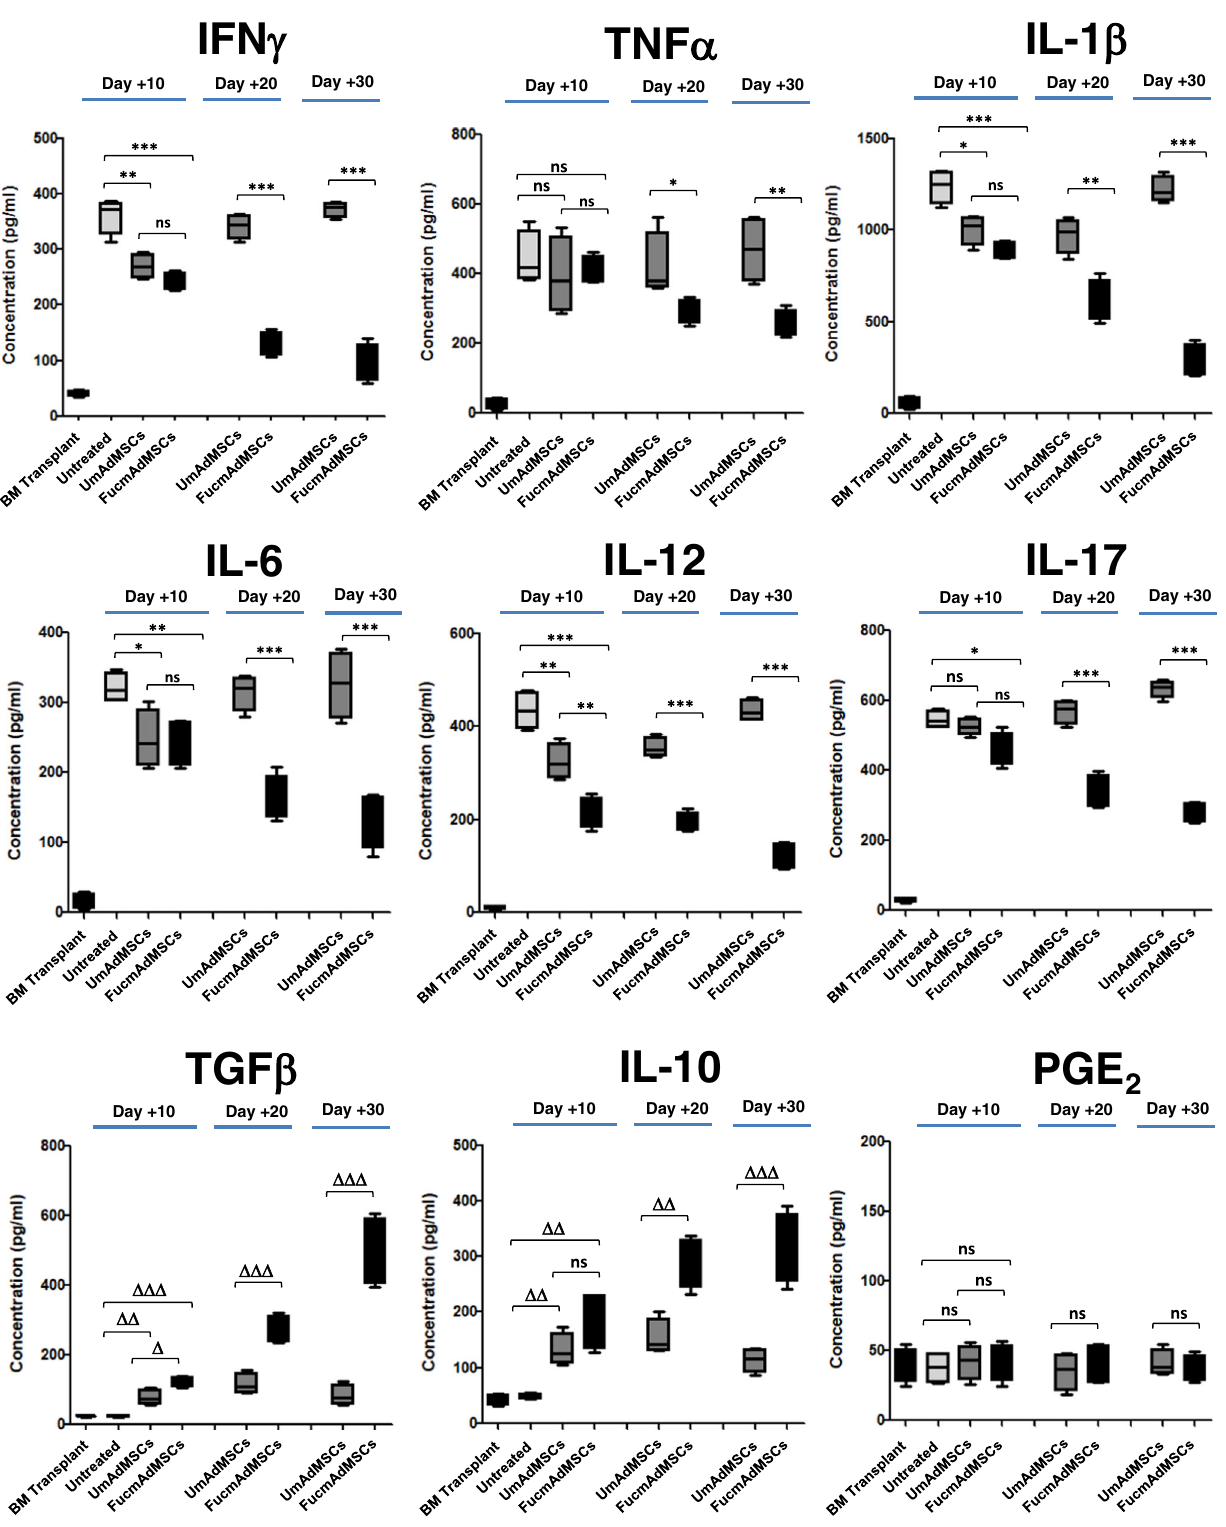
Fig. 4 Intravenous infusion of FTVII-treated mAdMSCs alters the systemic pro fi le of secreted pro-in fl ammatory and anti-in fl ammatory cytokines on mice with aGvHD. Plasma concentrations of the pro-in fl ammatory factors IFN γ , TNF α , IL-1 β , IL-6, IL-12, and IL-17, and anti- in fl ammatory molecules TGF β , IL-10, and PGE 2 were measured on days + 10, + 20, or + 30 post-transplantation by ELISA. Data are presented as mean ± SD of n = 5 animals per group. As shown in the panels, plasma levels of all the in fl ammatory cytokines tested were signi fi cantly decreased with administration of FucmAdMSCs (* p < 0.05, ** p < 0.01, *** p < 0.001), whereas levels of anti-in fl ammatory cytokines TGF β and IL- 10 were markedly increased ( Δ p < 0.05, ΔΔ p < 0.01, ΔΔΔ p < 0.001), analyzed by one-way ANOVA with Tukey ’ s multi p le-comparisons